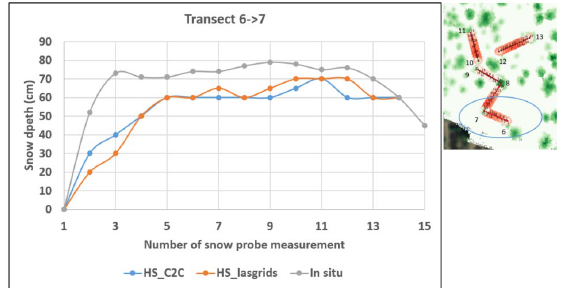
Figure 7 . Snow depths within a transect, comparing in-situ